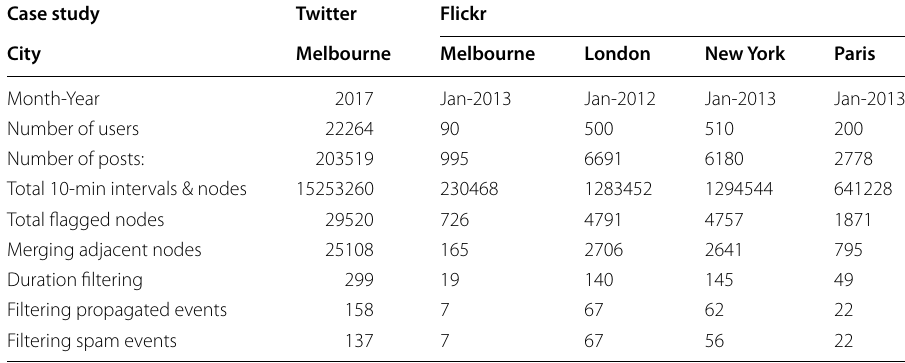
Table 6 Event detection results for Flickr and